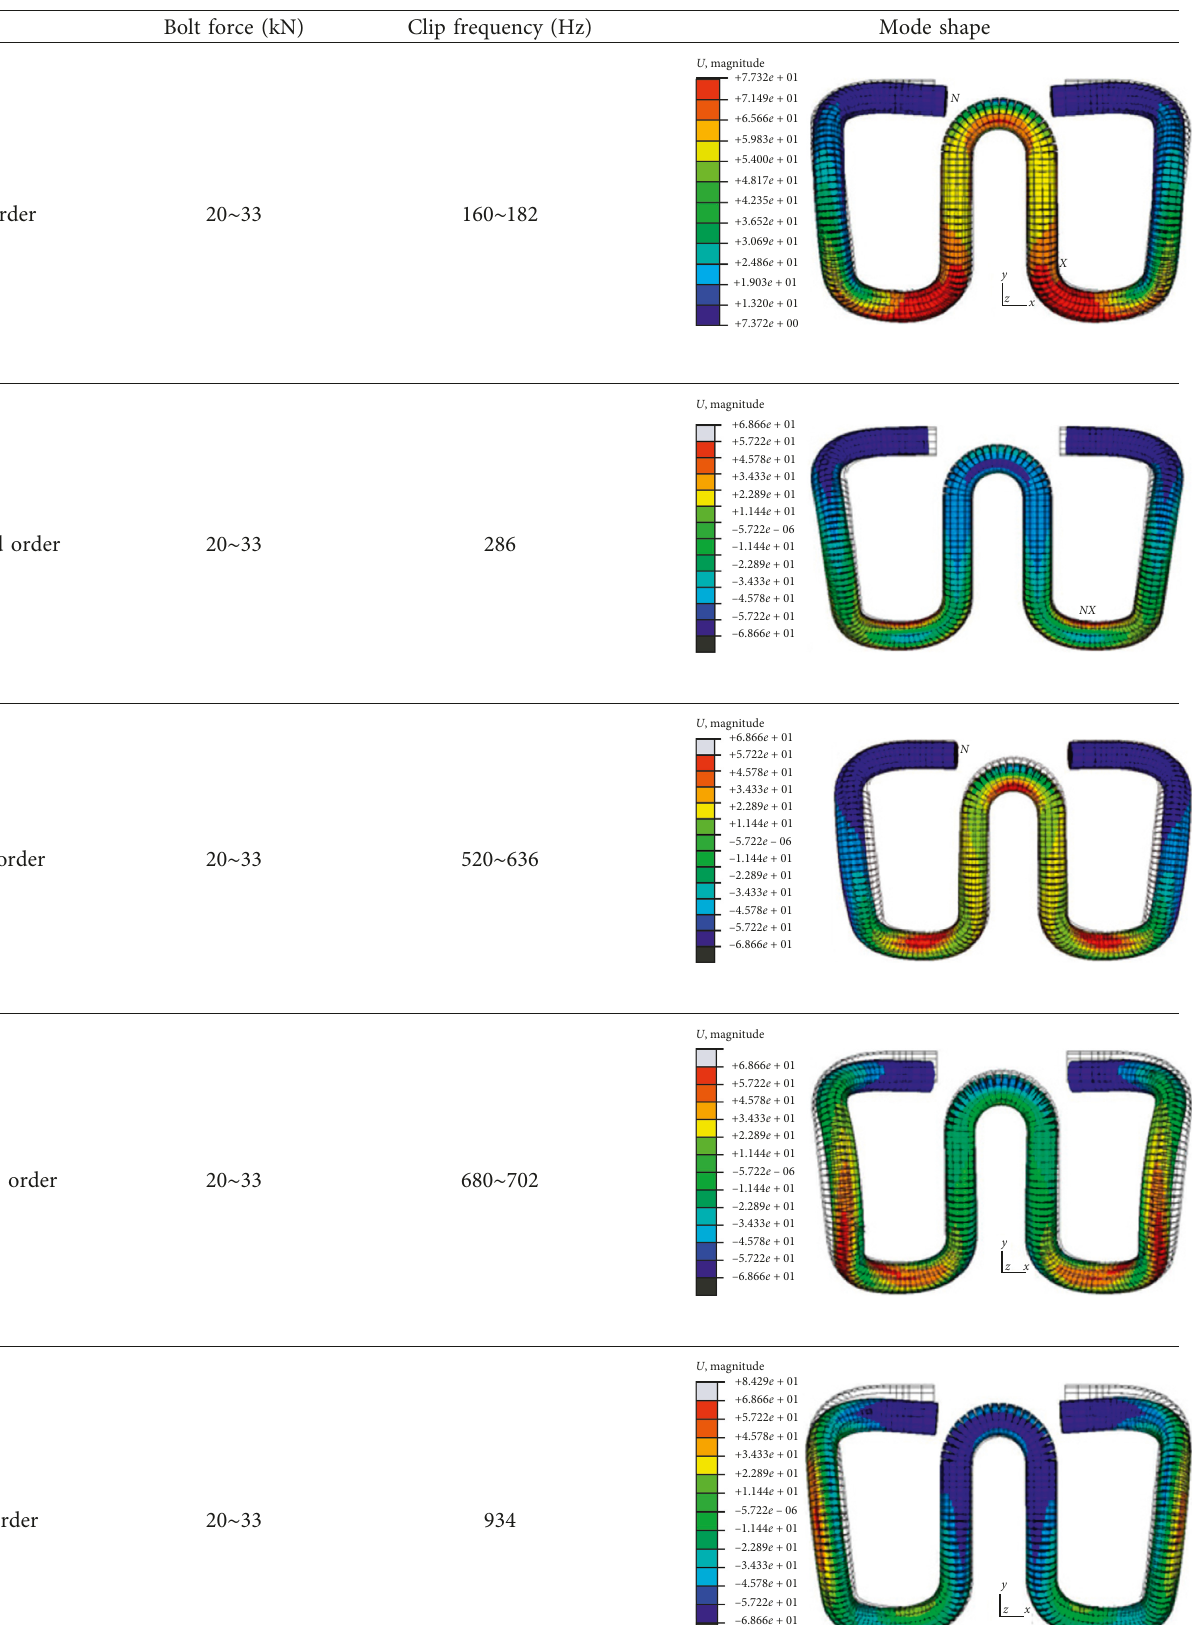
Table 3: Modal frequency and mode shape of the rail